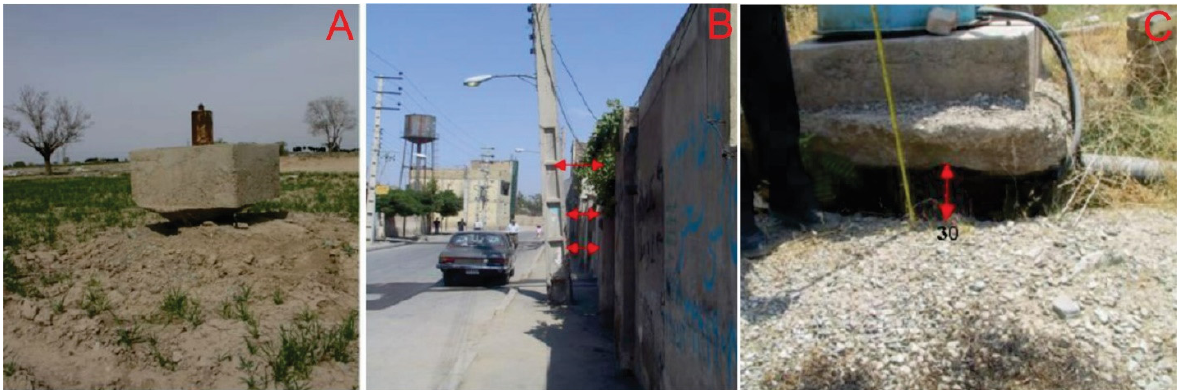
Figure 11. Damages due to the overexploitation of the aquifer in Tehran: ( Α ) uplifting of boreholes (Sabashahr). ( Β ) damage to the electricity network red arrows showing the deviation from the vertical (Sabashahr). ( C ) Damaged boreholes suggesting a drop of 30 cm (Eslamshahr and Ahmadabad) [193] .